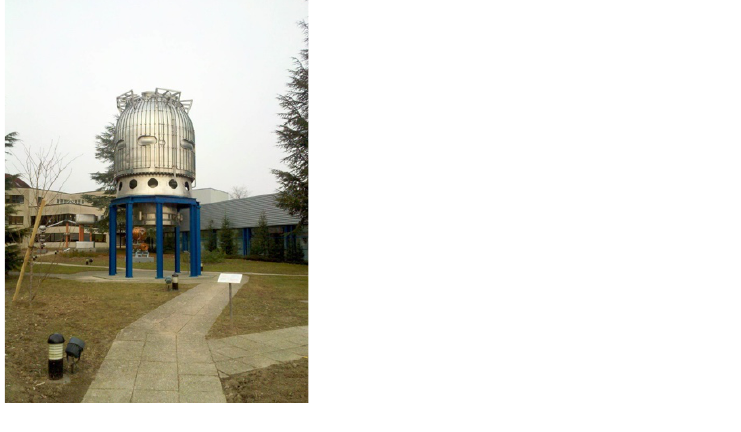
Fig. 1 The Big European Bubble Chamber (BEBC) in the CERN Microcosm